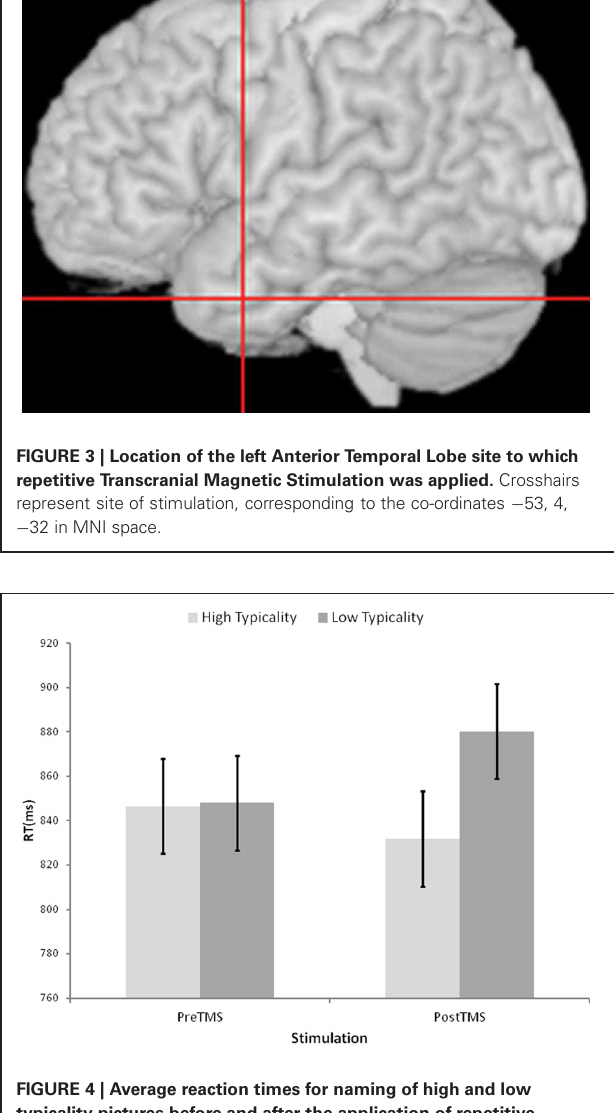
FIGURE 4 | Average reaction times for naming of high and low typicality pictures before and after the application of repetitive Transcranial Magnetic Stimulation to the left Anterior Temporal Lobe. Error bars represent ± within-participants 90% confidence intervals computed according to Loftus and Masson (1994, Equation 4, p.